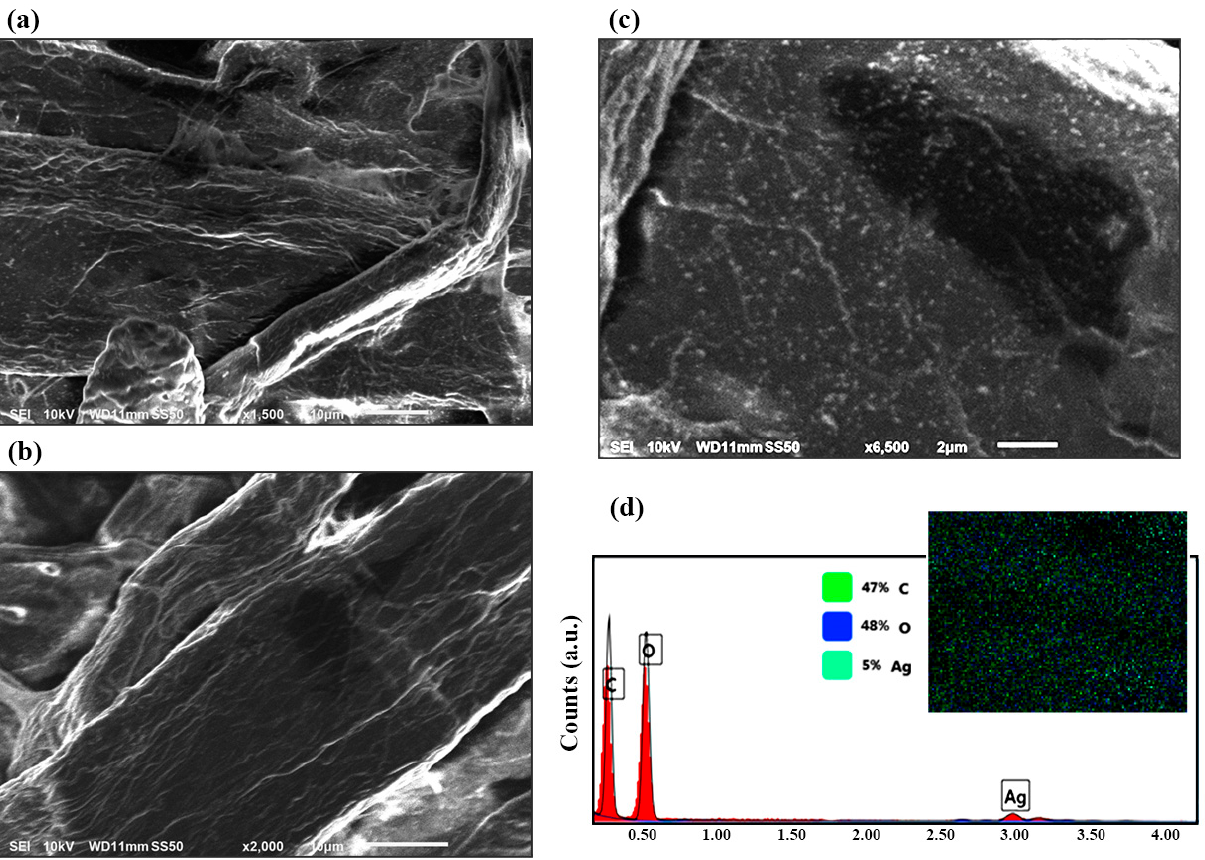
Figure 2. SEM micrographs of the paper after ( a ) and before ( b ) decorating the surface with silver nanoparticles. ( c ) Close examination of the AgNPs on the surface of the filter paper. ( d ) EDAX results of the decorated surface, confirming the presence of silver. Scale bars are 2 μ m for ( c ) and 10 μ m for ( a , b ).